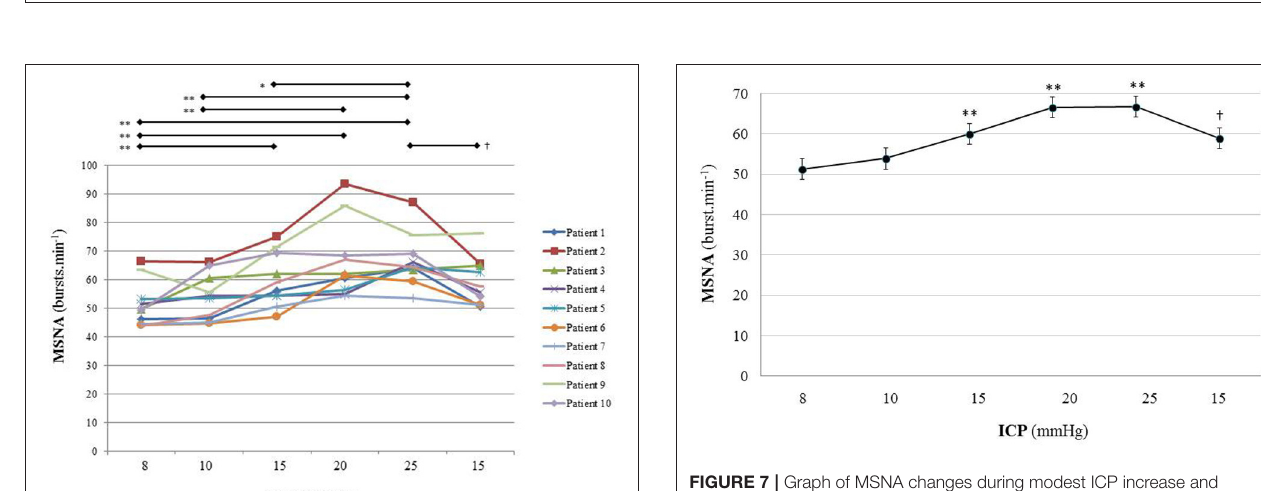
FIGURE 5 | Example of a patient recording with raw signals of ICP, respiration, ABP and sympathetic activity during modest ICP rise. Example of a patient raw signal of ICP, respiration, ABP and neurogram of MSNA at baseline ICP ( ≈ 10 mmHg), ICP ( ≈ 20 mmHg) and plateau ICP ( ≈ 25 mmHg).